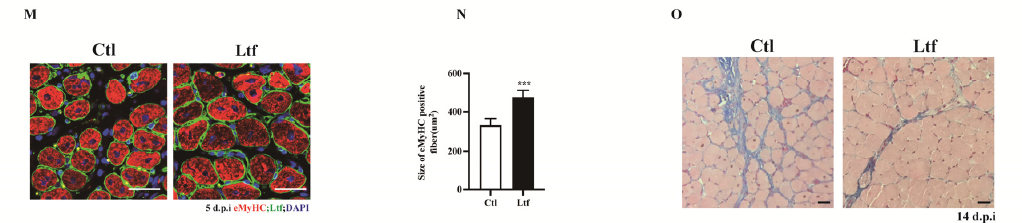
Figure 4. R- Ltf promotes proliferation of SCs in vivo and in vitro. ( A ) Satellite cells (SCs) isolated from wild-type (WT) mice after 1 day of adherent growth, treated with various concentrations of R- Ltf for 1 day, and then added CCK-8 to determine the OD value. ( B ) SCs isolated from WT mice after 1 day of adherent growth, treated with various concentrations of R- Ltf for 2 days, and then added CCK-8 to determine the OD value. ( C ) SCs isolated from WT mice after 1 day of adherent growth, treated with various concentrations of R- Ltf for 3 days, and then added CCK-8 to determine the OD value. ( D ) SCs isolated from WT mice after 1 day of adherent growth, treated with 1000 µ g/mL R- Ltf for other 3 days. Cells were labeled with EdU and DAPI. Scale bar: 20 µ m. ( E ) Quantitative analysis of the frequency of EdU+ positive cells. ( F ) SCs isolated from WT mice after 1 day of adherent growth and treated with 1000 µ g/mL R- Ltf for other 3 days. Cells were labeled with MyoD, Ki67 and DAPI. Scale bar: 20 µ m. ( G ) Quantification of the percentage of MyoD + Ki67 + double-positive cells. ( H ) Representative individual and merged photomicrographs of day 3 post-injury TA muscles of WT; following consecutive intraperitoneal injection of R- Ltf for 3 days, the cells were labeled with EdU and DAPI. Scale bars: 20 µ m. ( I ) Quantitative analysis of the frequency of EdU+ positive cells. ( J ) Representative photomicrographs of hematoxylin and eosin (H&E)-stained sections of injured TA muscle of WT at day 5 after BaCl 2 injection, with consecutive intraperitoneal injection of R- Ltf for 5 days. Scale bar: 30 µ m. ( K ) Quantification of the ratio of regenerating myofibers containing two or more centralized nuclei per field at day 5 post-injury. ( L ) Statistical analysis of mean area of TA muscle cross-sections (CSA) in adult WT mice 5 days after injury. ( M ) Representative overlaid photomicrographs of TA muscle sections of WT mice 5 days post-injury, followed by consecutive intraperitoneal injection of R- Ltf for 5 days, after immunostaining for eMyHC (red) and laminin (green). Nuclei were labeled by DAPI. Scale bar: 30 µ m. ( N ) Average CSA of eMyHC-positive fibers in TA muscle 5 days post-injury. ( O ) Representative photomicrographs of Masson-stained sections show collagen fibers in damaged TA muscles in WT mice at day 14 after BaCl 2 injection, intraperitoneal injection of R- Ltf for 14 days. Scale bar: 30 µ m. n = 6 in each group. * p < 0.05; ** p < 0.01; *** p < 0.001. Values without a common letter are significantly different at p <